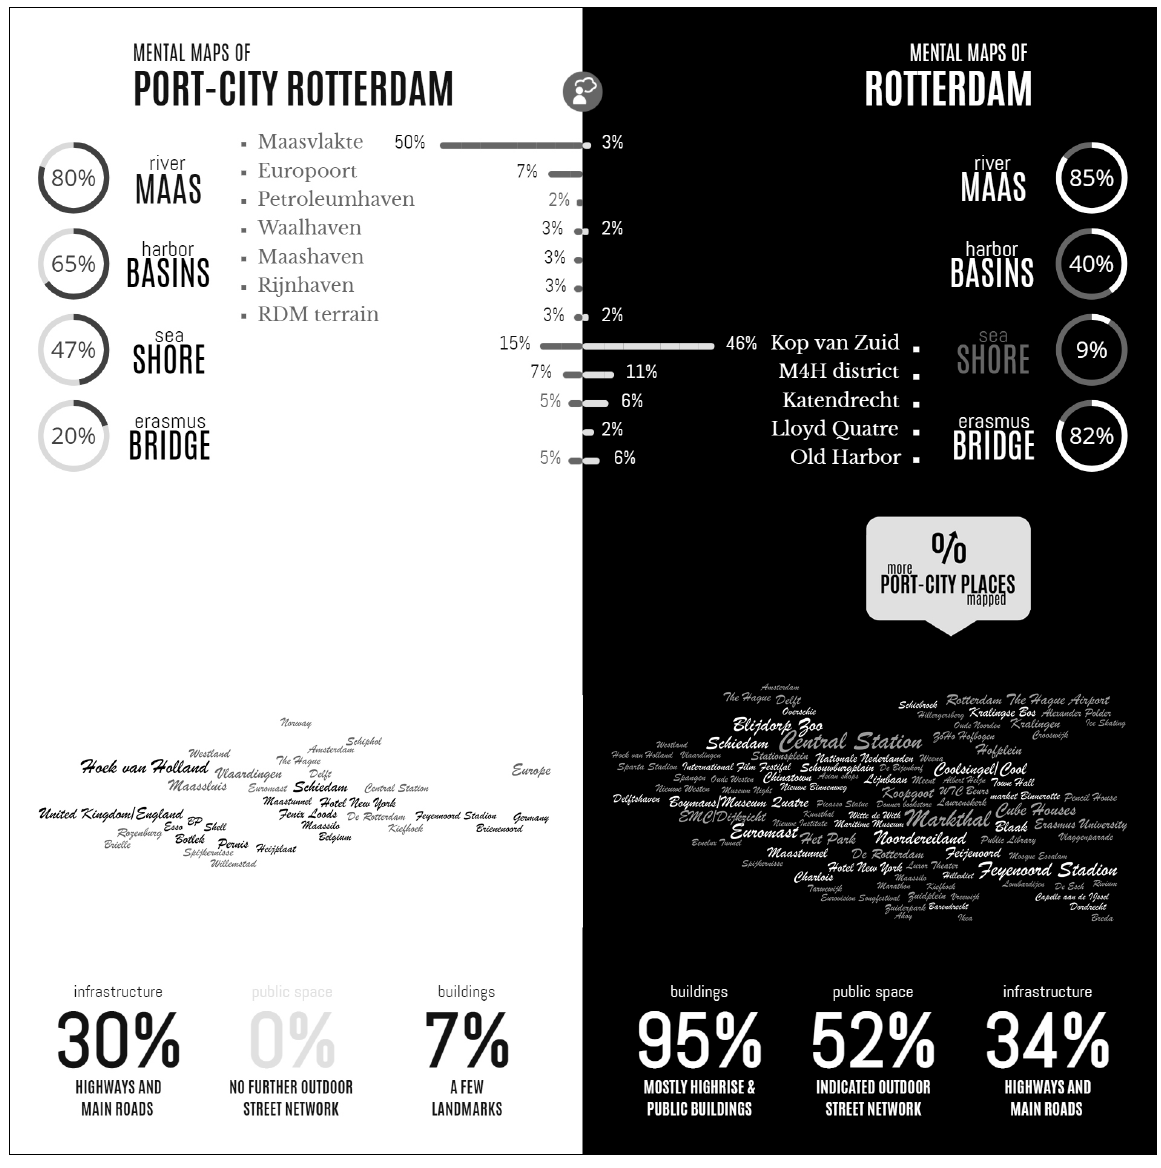
Infographic of the Comparative Analyses on the two Sets of Mental Maps, credits Maurice